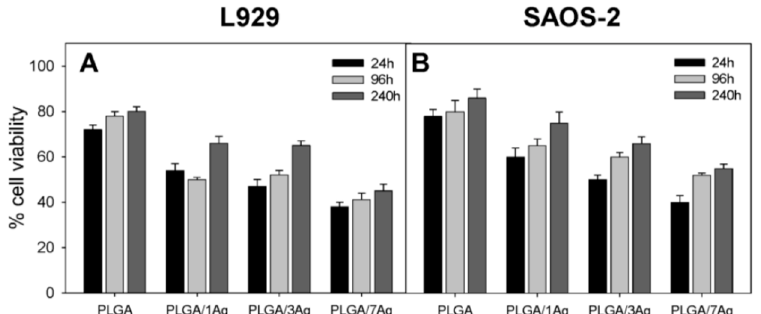
Figure 16. Antibacterial activity of dense PLGA and its PLGA / AgNPs nanocomposite films against ( A ) S. aureus and ( B ) E. coli incubated for 3 and 24 h at 37 °C. The percentage viability was determined by setting the bacterial cells grown onto the tissue culture plate (TCP) wells to 100%. Error bars indicated standard errors of the means, and ** denoted statistical significance, p < 0.01.